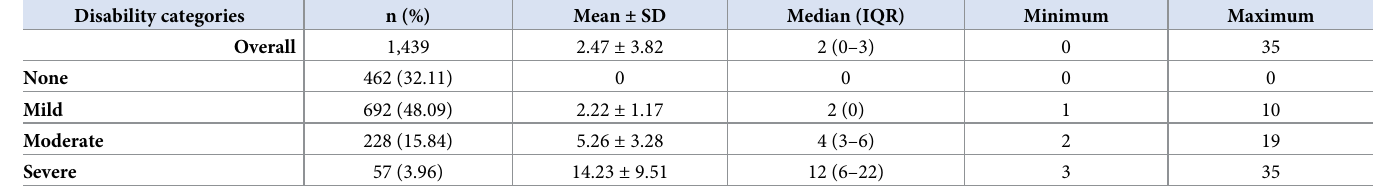
Table 3. Mean, median, minimum and maximum CFM scores based on disability categories (n = 1,439). Disability